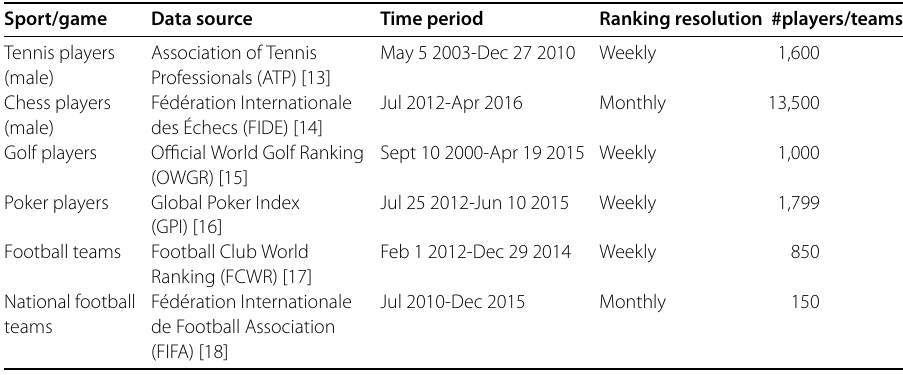
Tablelistingthemainpropertiesoftherankingdataused here(includingdatasource,timeperiod,rankingresolution,and numberofplayers/teams). Inordertohaveahomogeneousdistributionofrankingsnapshotsandthesamenumberof players/teams ineachsnapshotforagivenactivity,wedisregardsomedatafortheATP,FIDE,OWGR,GPI,andFIFAdatasets, asexplained inthemaintext.